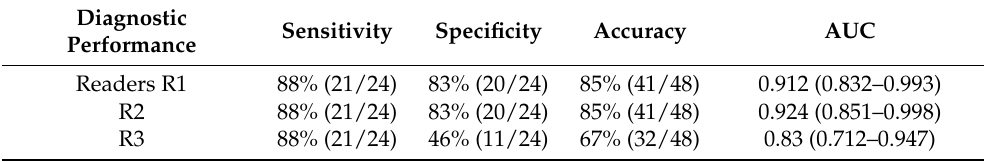
Table 4. Diagnostic performance of radiologists after correlation with results from radiomics